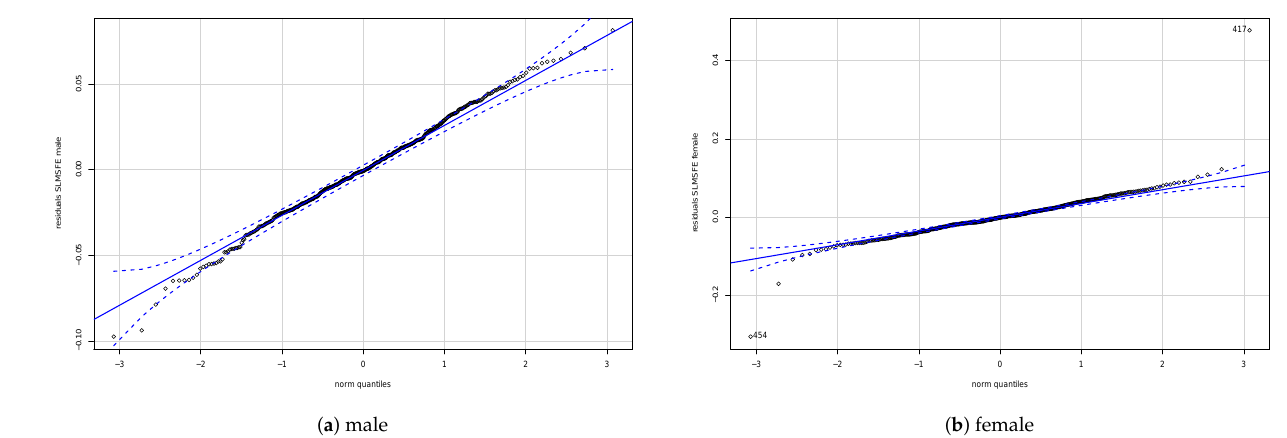
Figure 5. Normality of the SLMSFE model residuals for males and